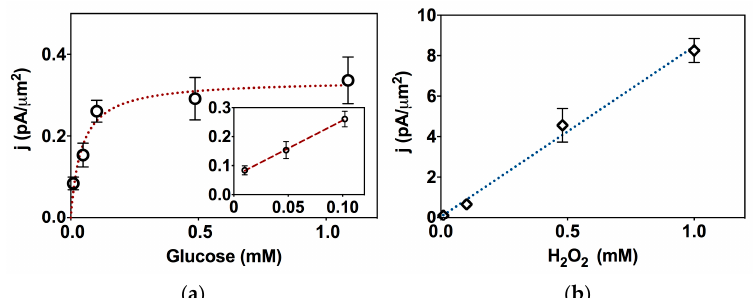
Figure 1. ( a ) A reproducible calibration curve for glucose using the glucose oxidase and gold nanoparticle modified carbon fiber microelectrode (GOx–AuNP–CFME) ( n = 7–10) when recording